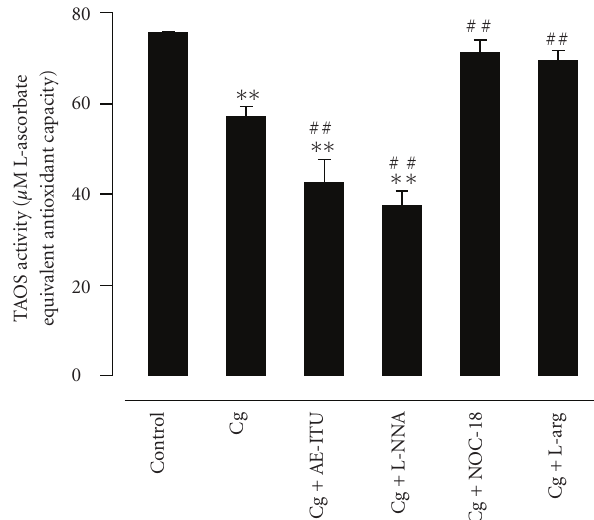
Figure 8: E ff ect of AE-ITU, L-NNA, NOC-18, and L-arginine on total antioxidant status (TAOS) activity in pleural exudates 6 hours after Cg challenge. Data are expressed as mean ± S.E.M. from 6 to 8 rats. ∗∗ P < . 01 as compared to the control group; ## P < . 01 as compared to the Cg